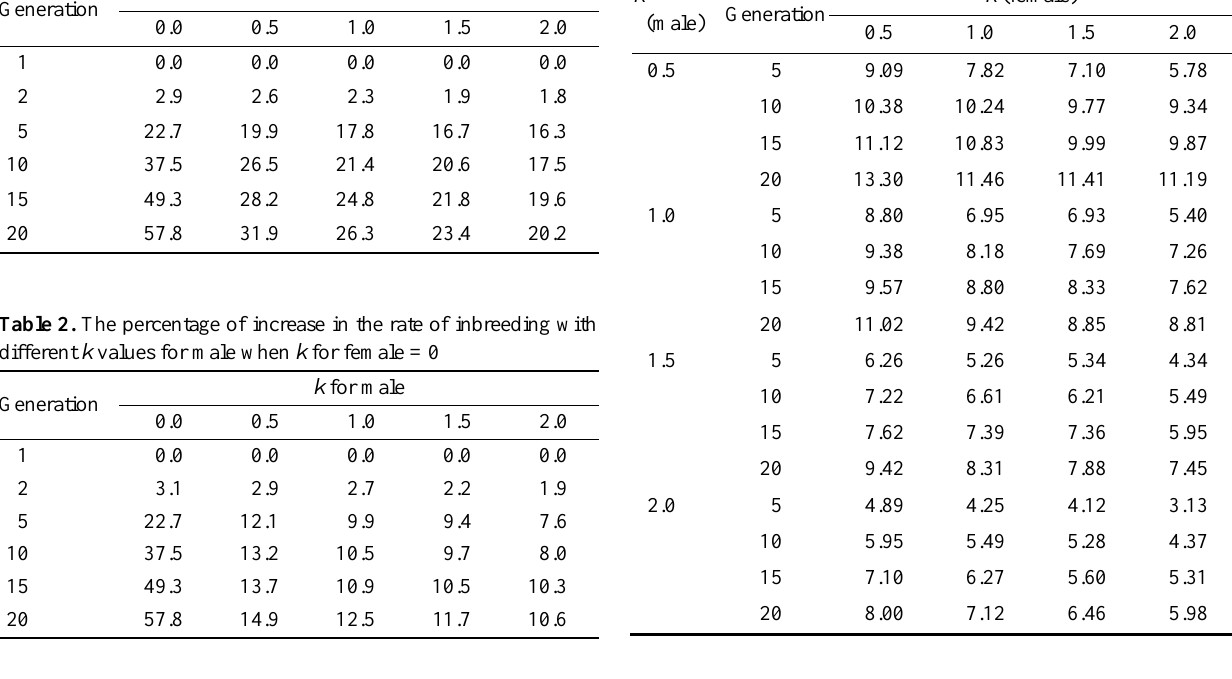
Table 1. The percentage of increase in the rate of inbreeding with different k values for female when k for male = 0 Generation